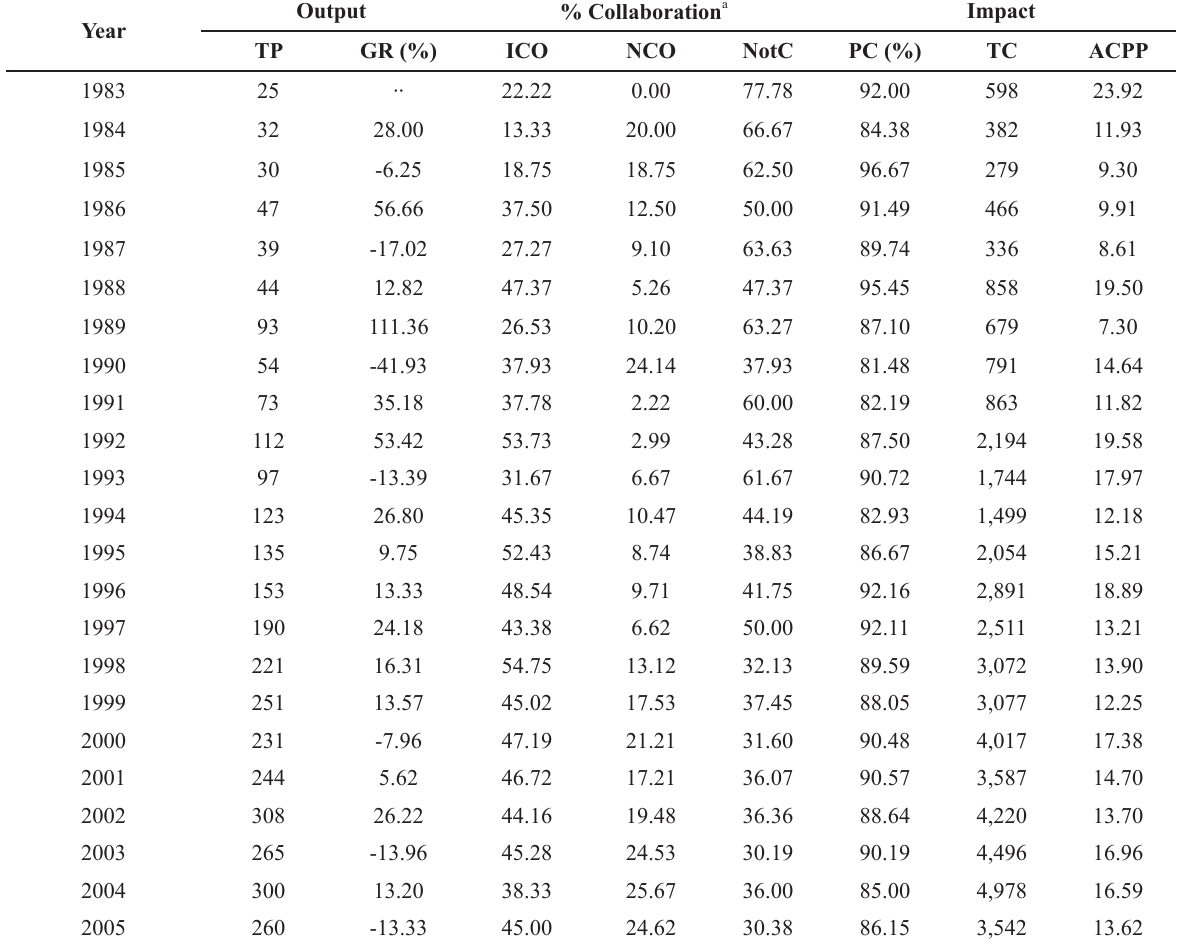
Figure 1 - Growth dynamics of Brazilian and international HEP publications, 1983-2013. The right vertical axis is for the TP Brazil and the left vertical axis for the TP Annual evolution of Brazilian HEP scientific activity, 1983-2013.